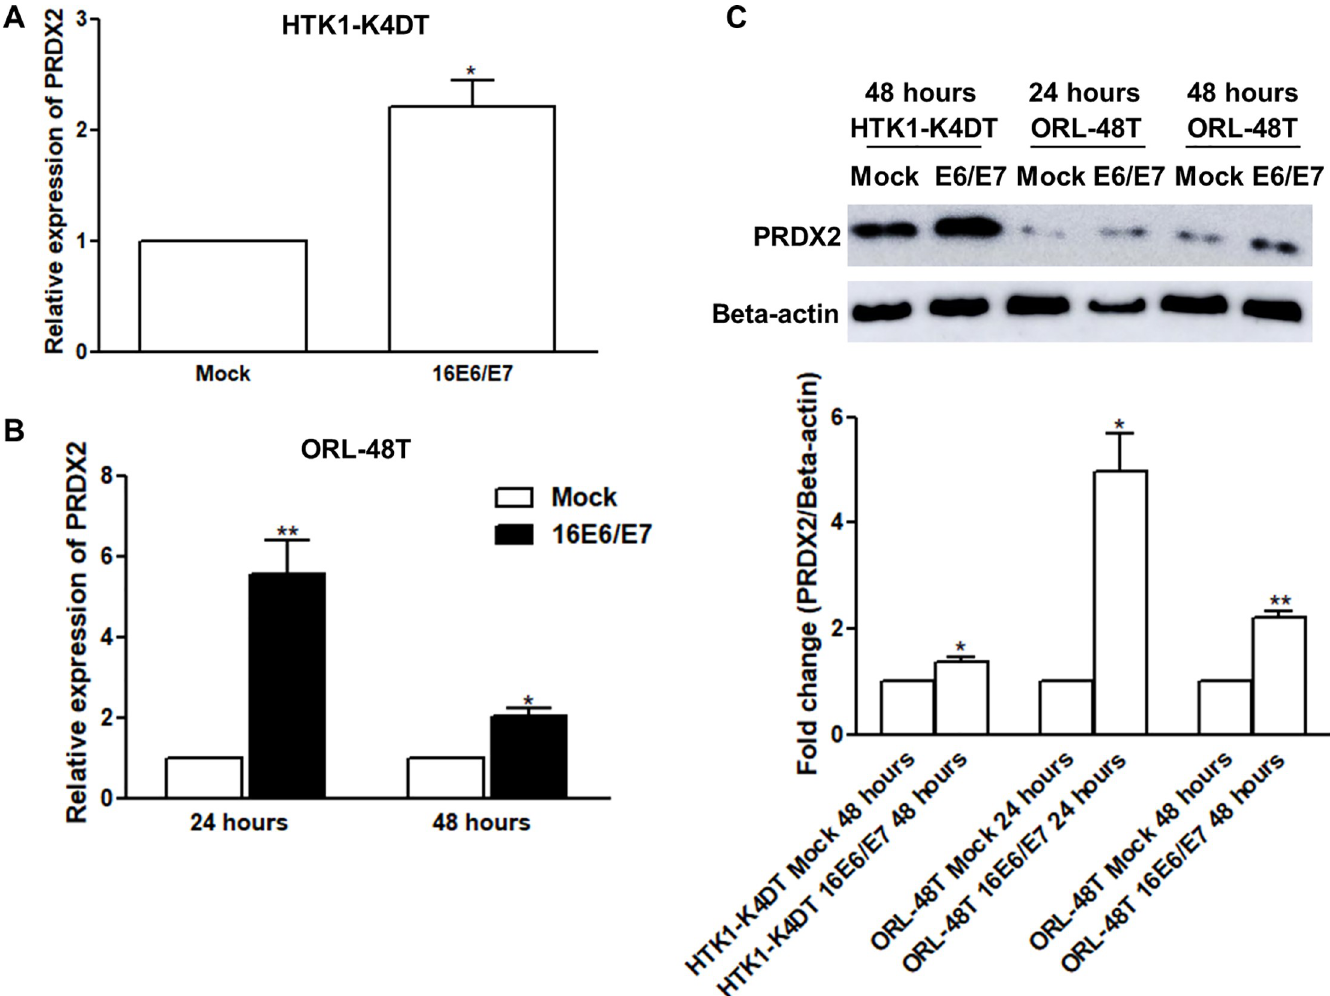
Fig 2. The level of PRDX2 mRNA and protein in HTK1-K4DT and ORL-48T cells transiently transfected with pIRES2-16E6/E7. Levels of PRDX2 mRNA and protein in mock (pIRES2)-transfected and HPV16 E6/E7 (pIRES2-16E6/E7)-transfected HTK1-K4DT (the immortalized human tongue keratinocyte) cells (A) and ORL-48T (well differentiated SCC that originated from mouth/gum) cells (B) was determined by Real-Time PCR and western blot. Each experiment was performed in triplicate. The protein intensity was measured using ImageJ 1.49v software. The protein intensity of PRDX2 was normalized with beta-actin to calculate the fold change (C). Differences in expression between mock and HPV16 E6/E7 treatments were statistically analyzed using paired t-tests. � and �� denote statistically significant differences as P < 0.05 and 0.01, respectively.